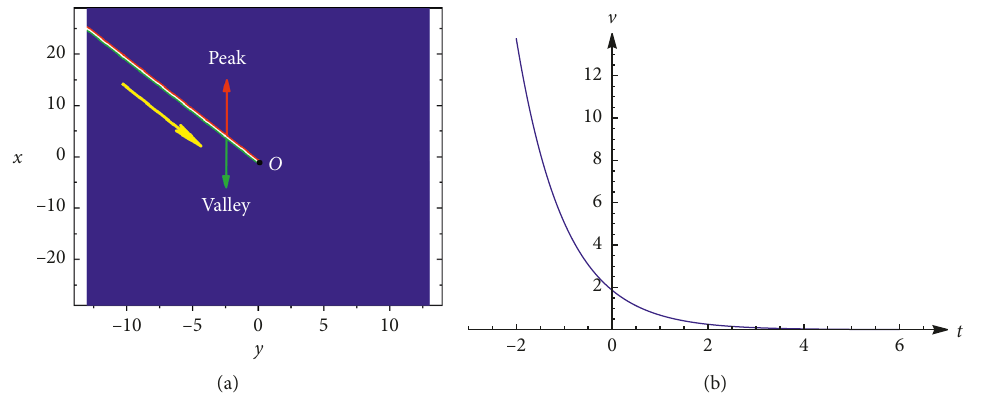
Figure 3: (a) The half-line-typed trajectory of the nonautonomous lump wave via the solution (9). (b) The velocity curve of the non- autonomous lump wave with time. The variable coefficients are taken as α as Figure